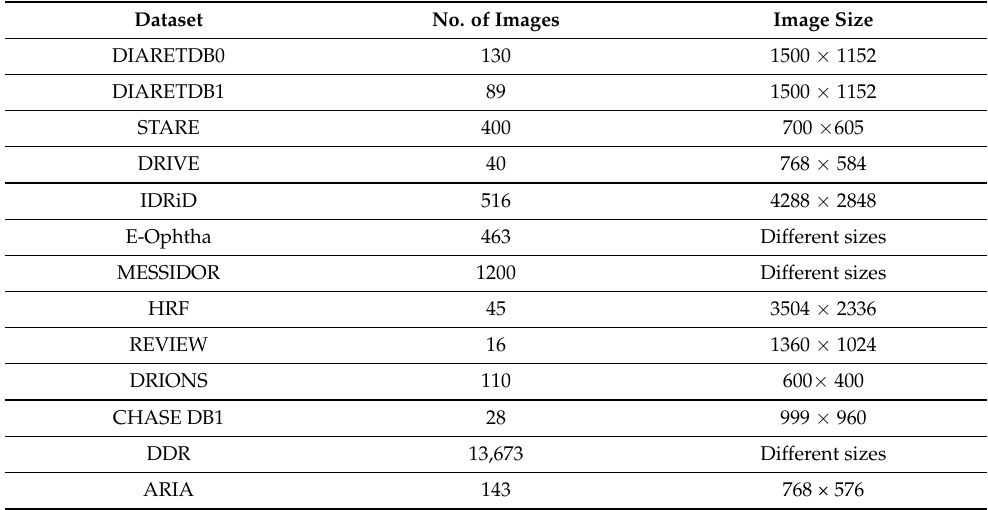
Table 3. Datasets used for Diabetic Retinopathy Segmentation/Lesion Detection.